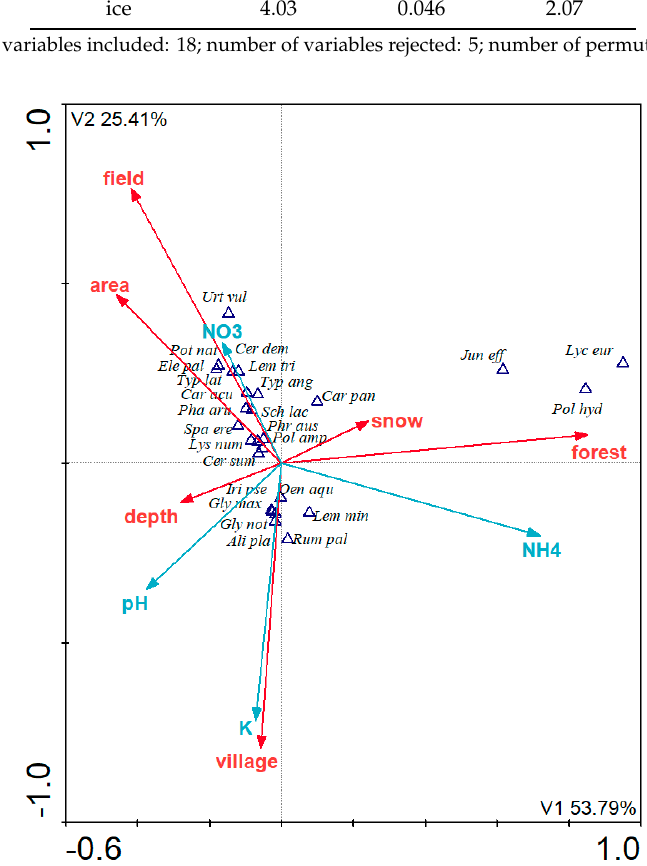
Figure 5. CCA analysis (n = 234) depicting the dependence between the macrophytes ( Ali pla— Alisma